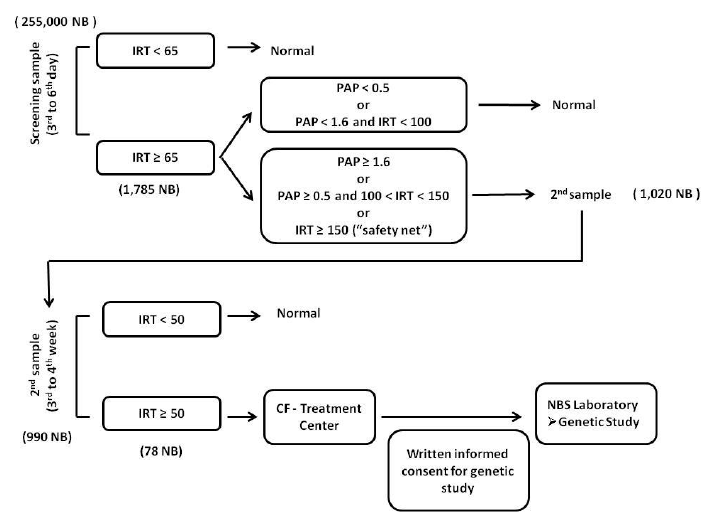
Figure 1. Algorithm used in the pilot study for CF-NBS in Portugal and the numbers of newborns at each stage. IRT (immunoreactive trypsinogen) and PAP (pancreatitis associated protein) are expressed in ng/mL.